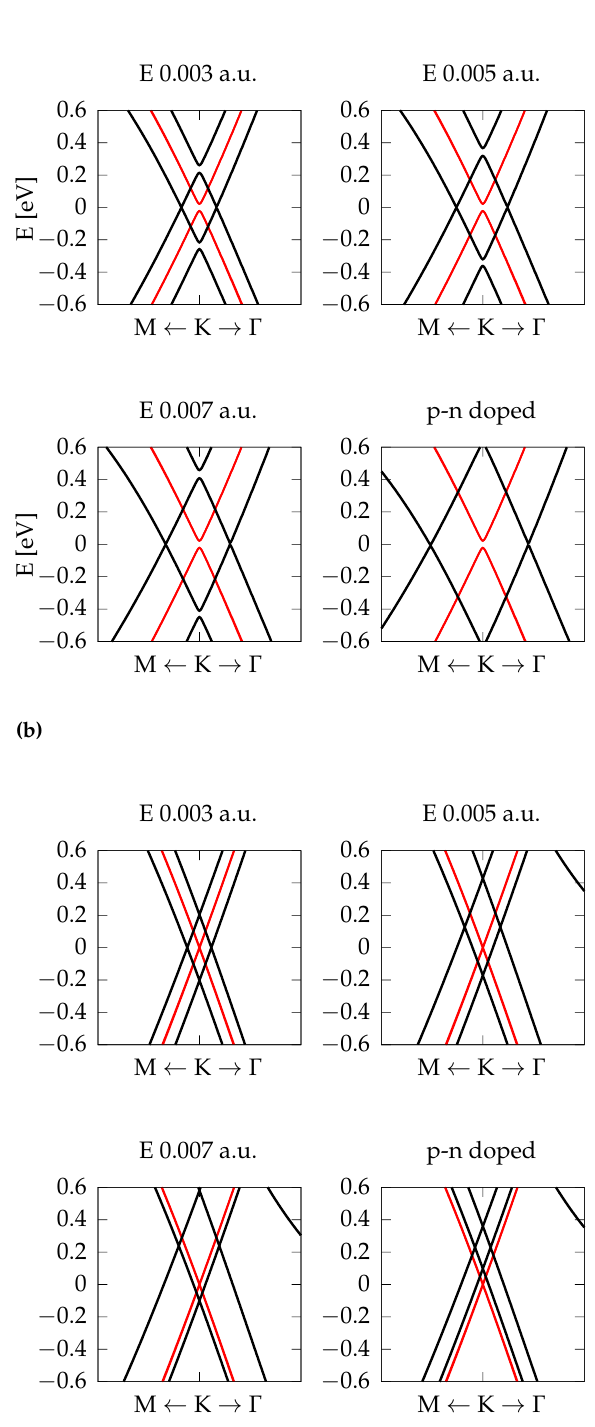
Figure 6. Black lines: The effect of three different external electric fields in a.u. and p-n doping on the band structure of C-BN-BN-C in a) AB-AA’-AB configuration and b) twisted configuration. With red lines we report results without electric field as a reference. The zero of the energy is set at the Fermi level. The scale on the x axis in a) and b) is not the same, hence the dissimilar slope of the bands does not indicate variations in the Fermi velocity of the carriers (see Table3).